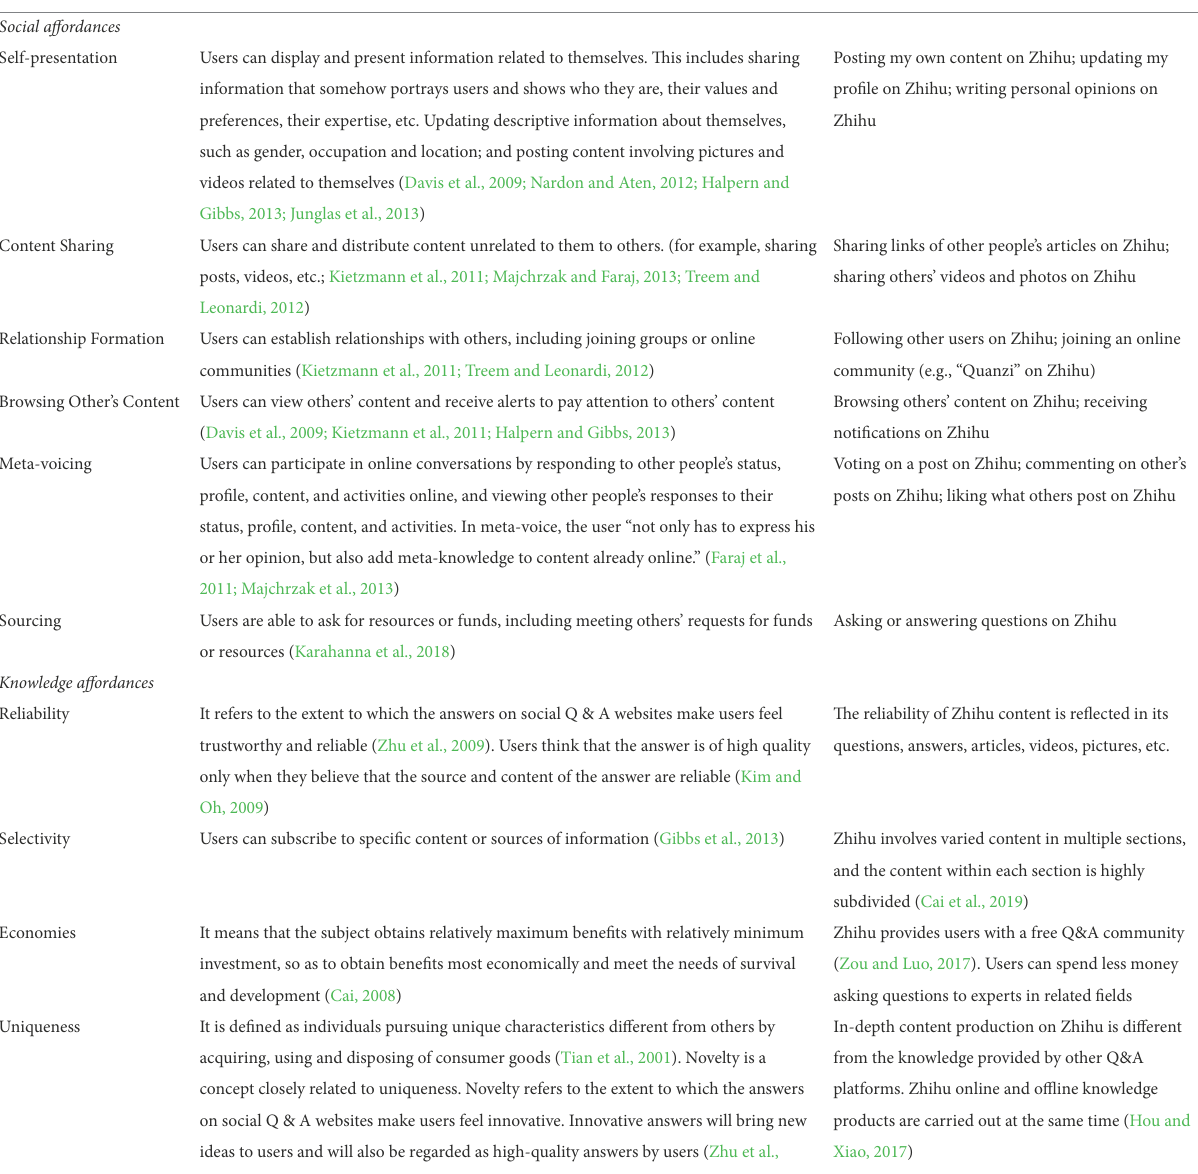
TABLE 1 Knowledge platform